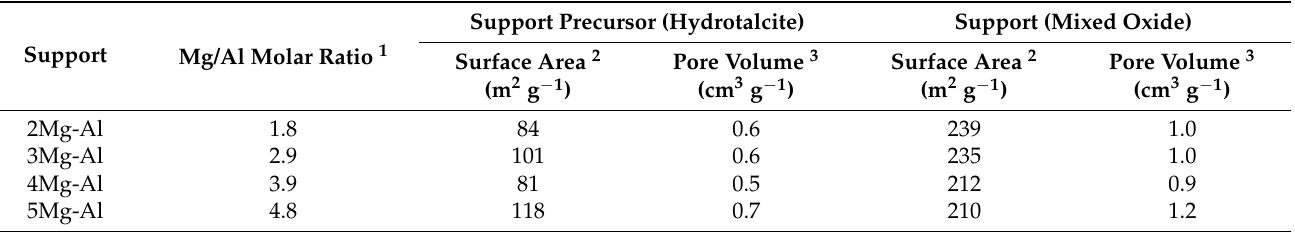
Figure 2. Nitrogen adsorption–desorption isotherms for the 5Mg-Al hydrotalcite (black lines) and 5Mg-Al mixed oxide (red lines). Table 1. Physicochemical properties of the support precursors (hydrotalcites) and the supports (mixed oxides)